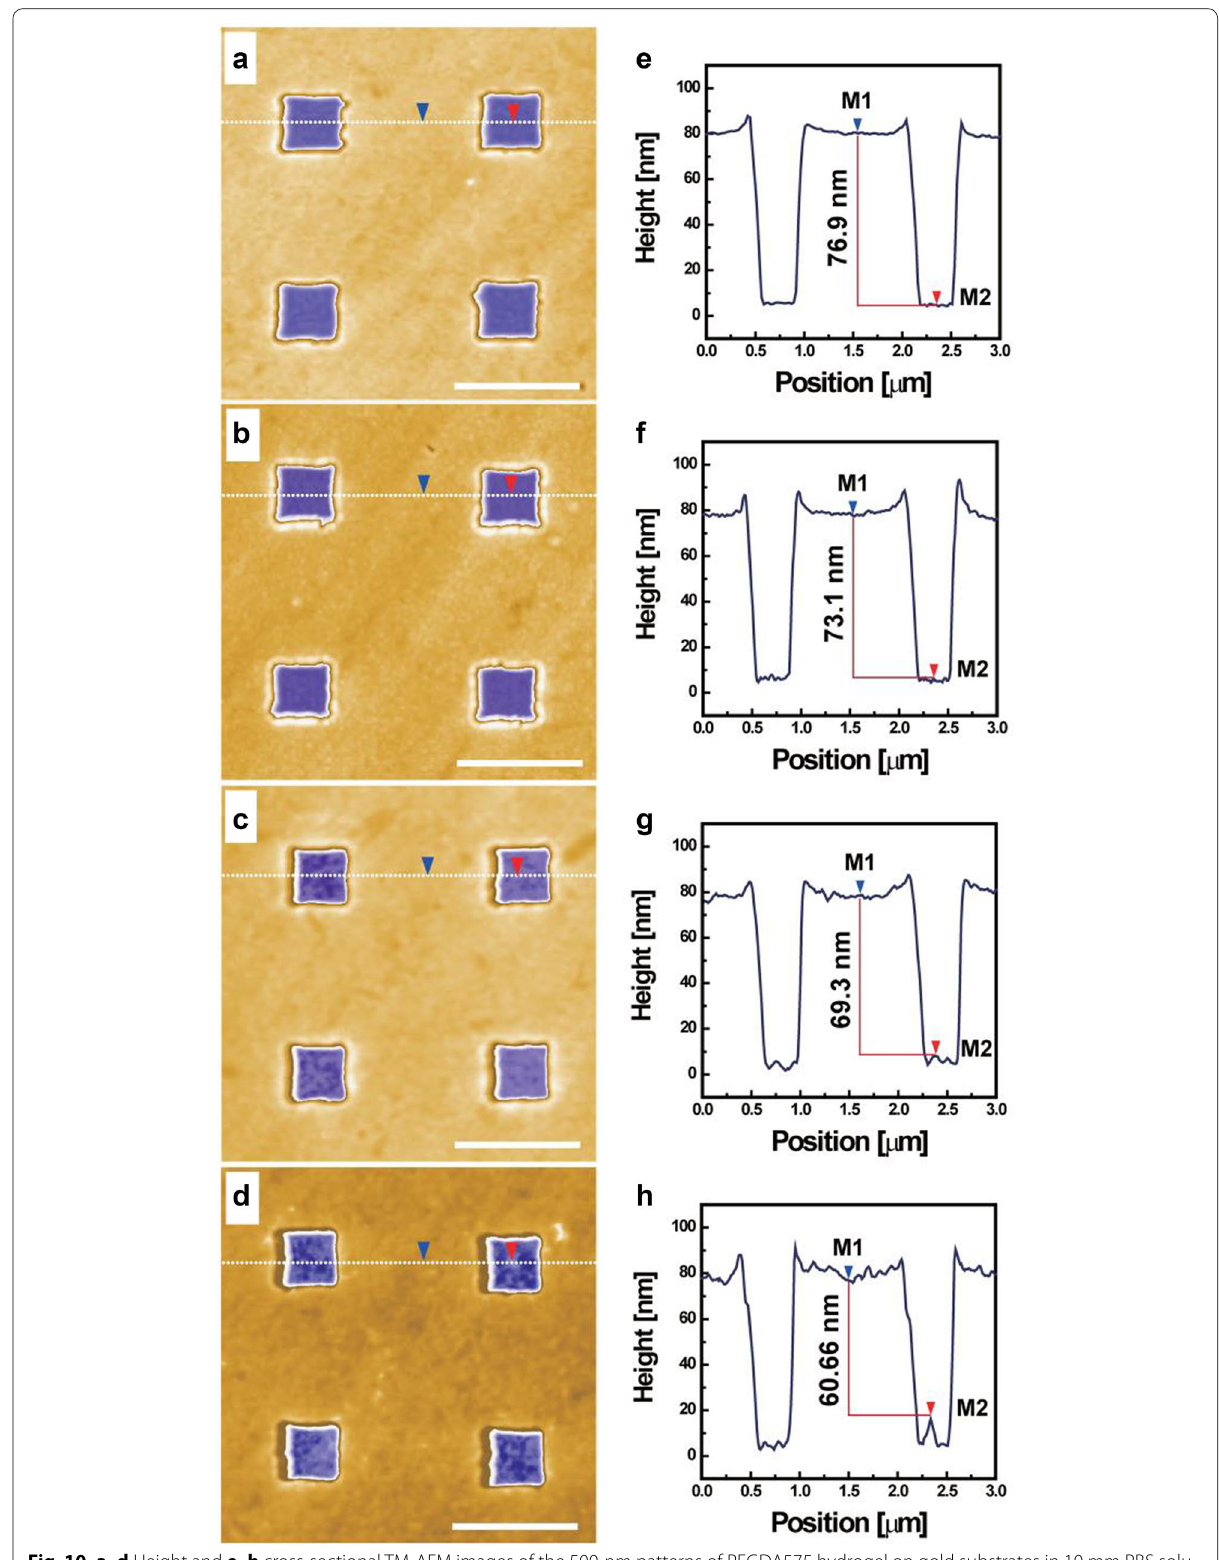
Fig. 10 a – d Height and e – h cross-sectional TM-AFM images of the 500-nm patterns of PEGDA575 hydrogel on gold substrates in 10 mm PBS solu- tion. a , e Hydrated state, b , f PEG mixed SAM-modified state, c , g SA-immobilized state, and d , h anti-bHSA-immobilized state. Scale bars: 1 μm